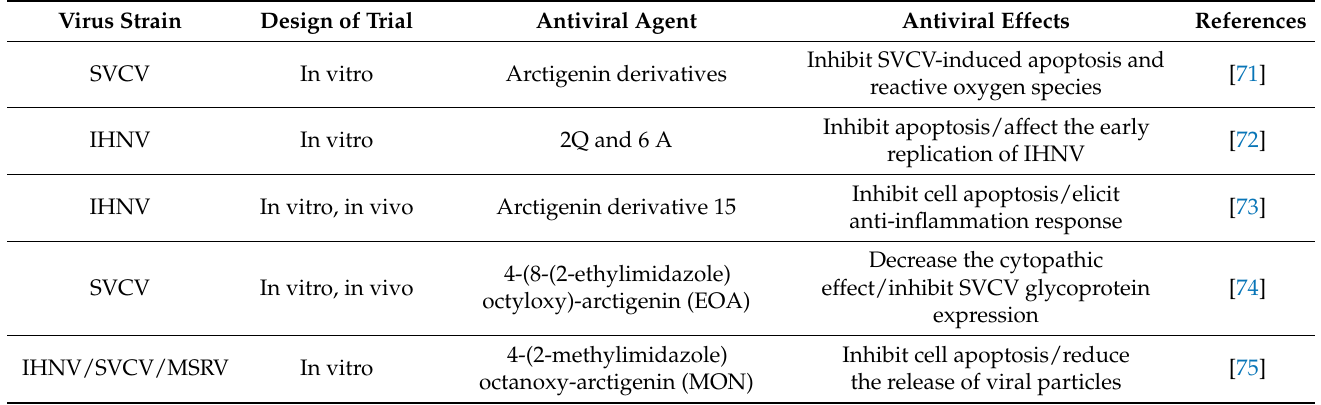
Table 6. Arctigenin derivatives against fish rhabdoviruses and their antiviral